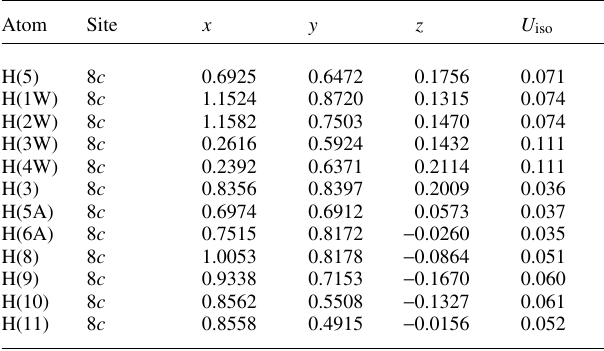
Table 2. Atomic coordinates and displacement parameters (in Å 2 )